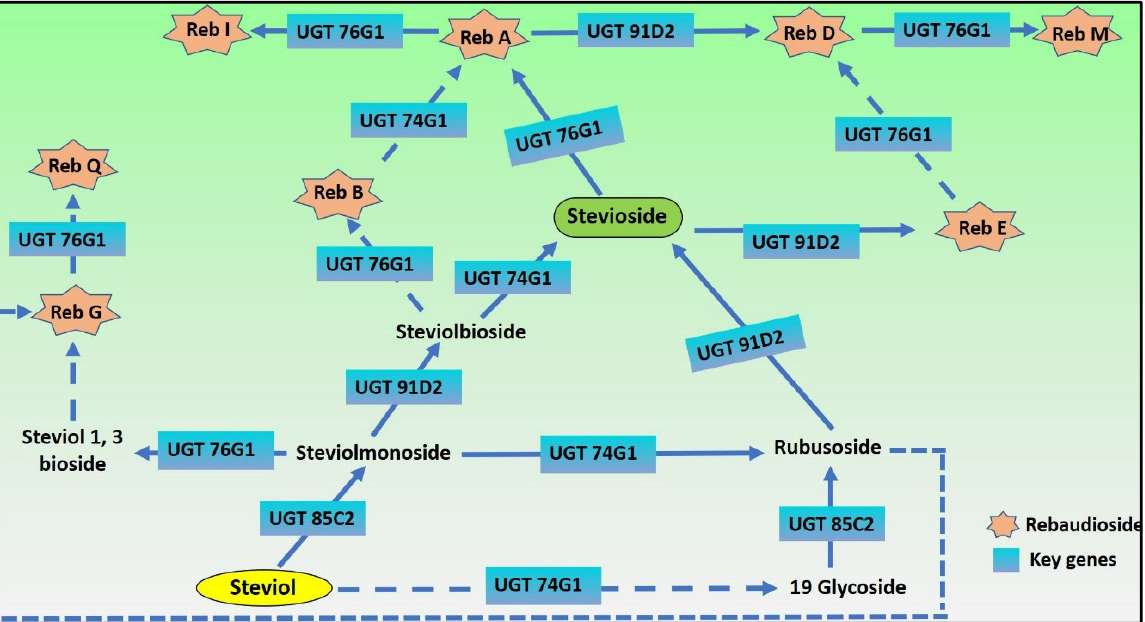
Figure 2. Glycosylation steps involved in the synthesis of steviol glycosides. Reb = Rebaudioside; UGT = UDP-dependent glycosyltransferases.